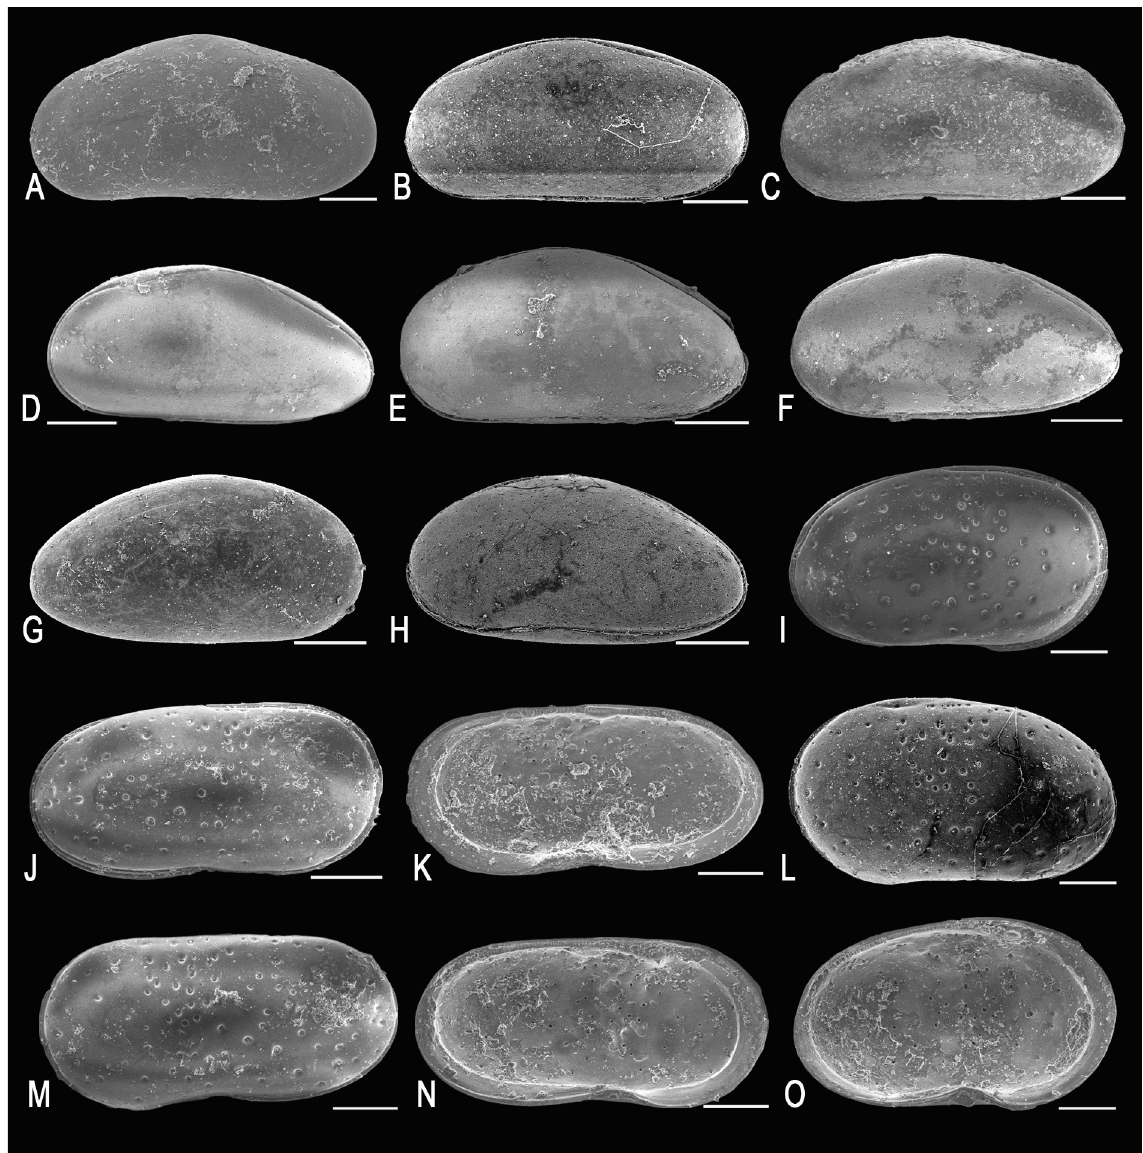
Fig. 5. Holocene ostracods from Samut Sakhon Province, Central Thailand. A–C . Aglaiocypris pellucida Mostafawi, 2003. A . Carapace, right lateral view, SUT-20SS-C003. B . Carapace, left lateral view, SUT-20SS-C007. C . Carapace, left lateral view, SUT-20SS-C003. – D–H . Propontocypris bengalensis Maddocks, 1969. D . Carapace, left lateral view, SUT-20SS-C012. E . Carapace, left lateral view, SUT- 20SS-C020. F . Carapace, left lateral view, SUT-20SS-C014. G . Carapace, right lateral view, SUT- 20SS-C027. H . Carapace, left lateral view, SUT-20SS-C022. – I–O . Sinocytheridea impressa (Brady, 1869). I . Carapace, female, right lateral view, SUT-20SS-C063. J . Carapace, male, right lateral view, SUT-20SS-C040. K . Internal view of right valve, male, SUT-20SS-C049. L . Carapace, female, left lateral view, SUT-20SS-C071. M . Carapace, male, left lateral view, SUT-20SS-C071. N . Internal view of left valve, male, SUT-20SS-C048. O . Internal view of left valve, female, SUT-20SS-C064. Scale bars = 0.1.